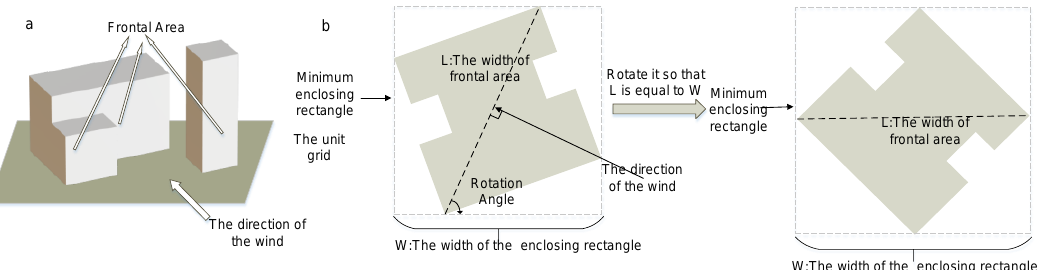
Figure 3. The principle of FAI calculation: ( a ) the frontal area of buildings in a unit grid; ( b ) schematic diagram of FAI calculation principle based on minimum enclosing rectangle.